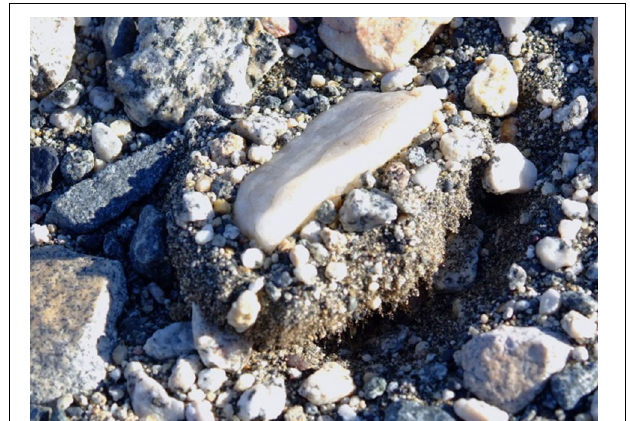
FIGURE 1 | Low altitude maritime soils in the McMurdo Dry Valleys.